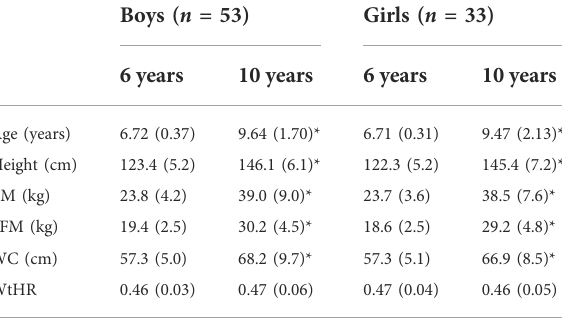
TABLE 1 Longitudinal anthropometric data, results are mean (standard deviation). BM, body mass; FFM, fat-free mass;